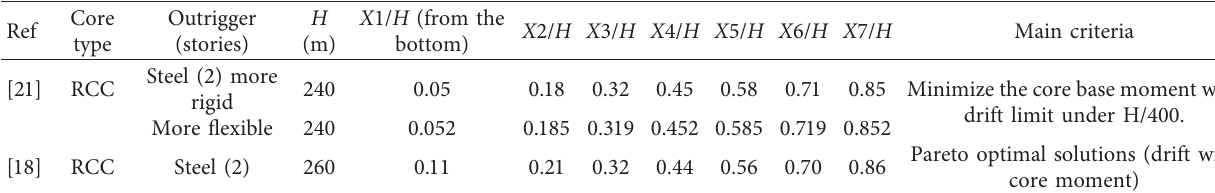
Table 11: Seven outrigger